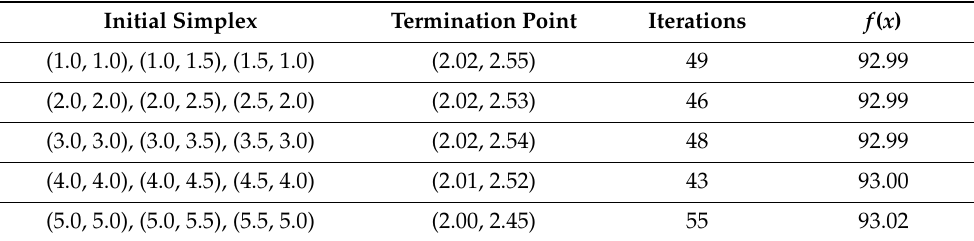
Table 1. Summary of Optimization Results Considering Balanced Voltage Distribution.